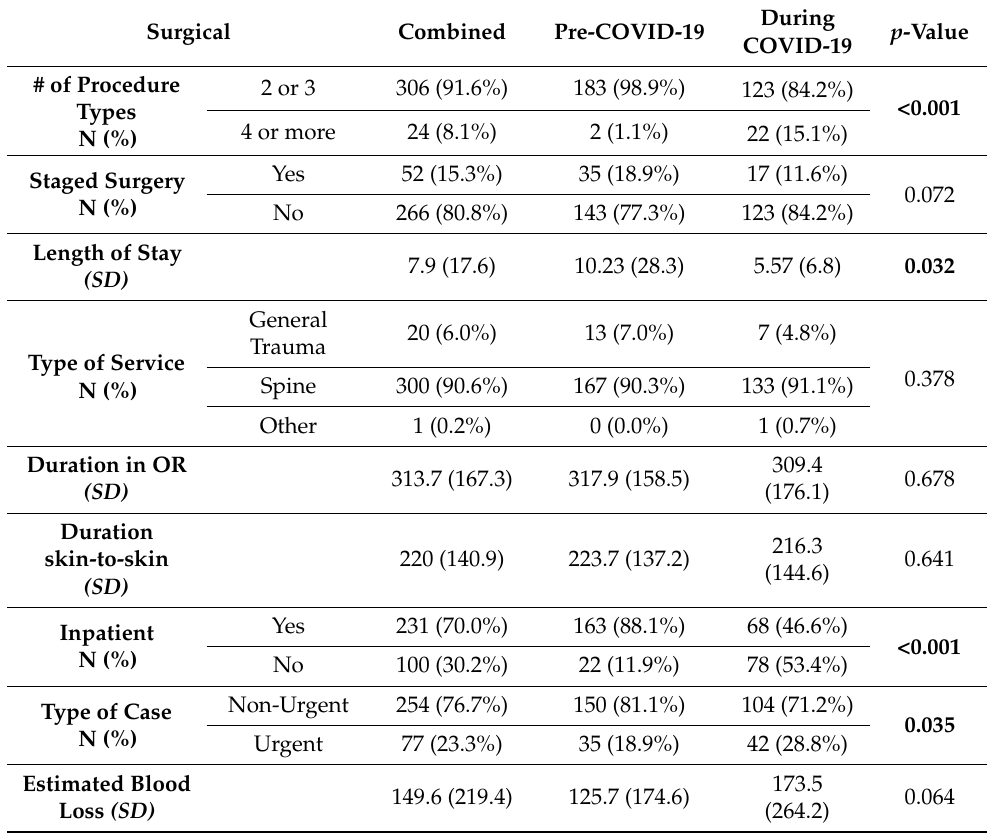
Figure 1. Procedure Types: Pre COVID-19 vs. During COVID-19. Significant group differences are indicated with an asterisk (*). Table 3. Comparison of Surgical Characteristics Pre COVID-19 and During COVID-19. Significant p -values are indicated in bold. # = number.